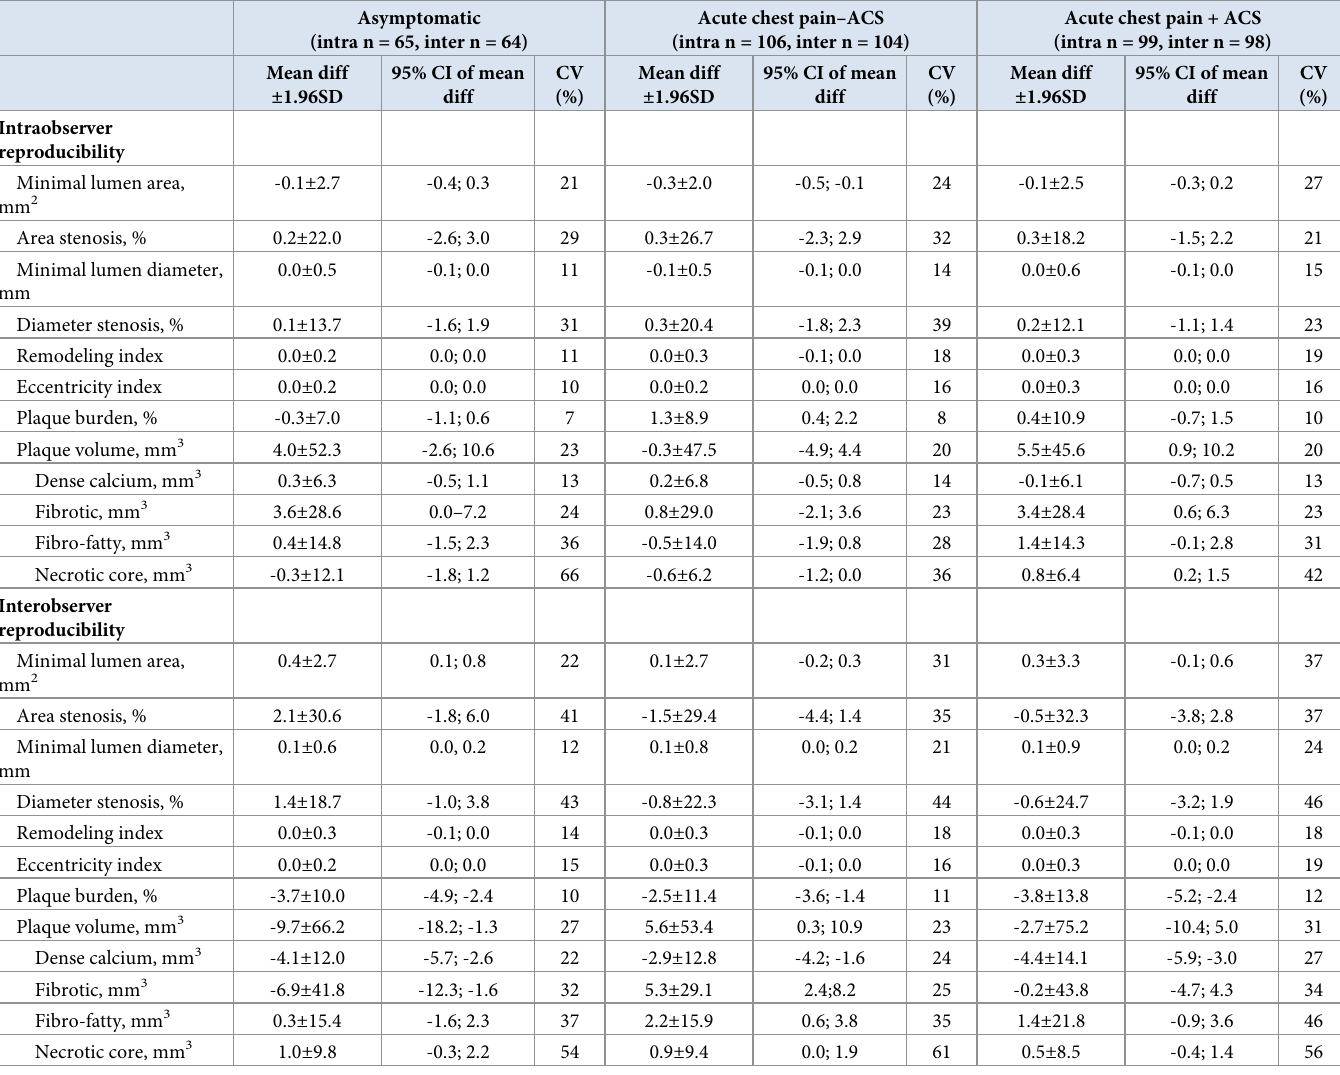
Table 4. Intraobserver and interobserver reproducibility in each cohort on a lesion basis in age and gender matched patients. Asymptomatic Acute chest pain–ACS (intra n = 65, inter n = 64) (intra n = 106, inter n = 104)